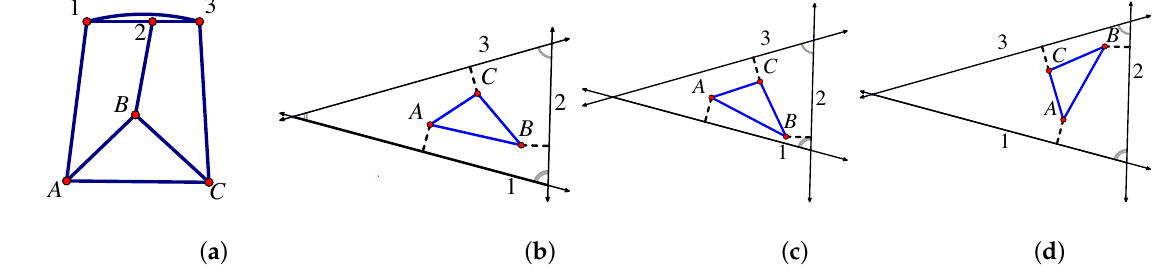
Figure 17. A Desargues framework with a collinear triangle ( a ) must have a non-trivial infinitesimal motion. When realised with sliders (the triangle of lines with fixed angles) as in ( b ) the three angles are dependent, so one can be omitted ( c , d ). There are additional realisations ( c , d ) arising from a finite